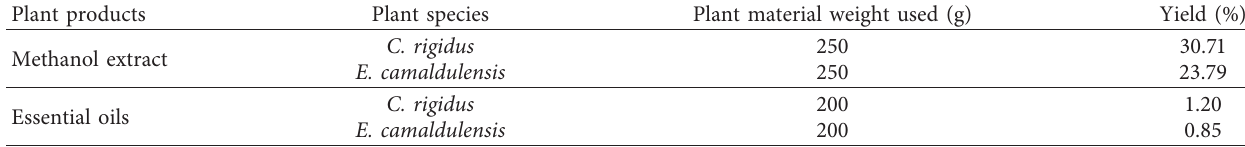
Table 1: Methanol extract and essential oil extraction yields of C. rigidus and E. camaldulensis .